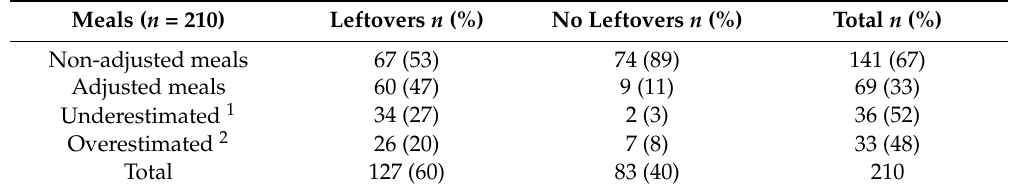
Table 3. Numbers of non-adjusted and adjusted meals (corrected by dietician after review of meal images) with or without leftovers assessed with five-day food records with active image-assistance.